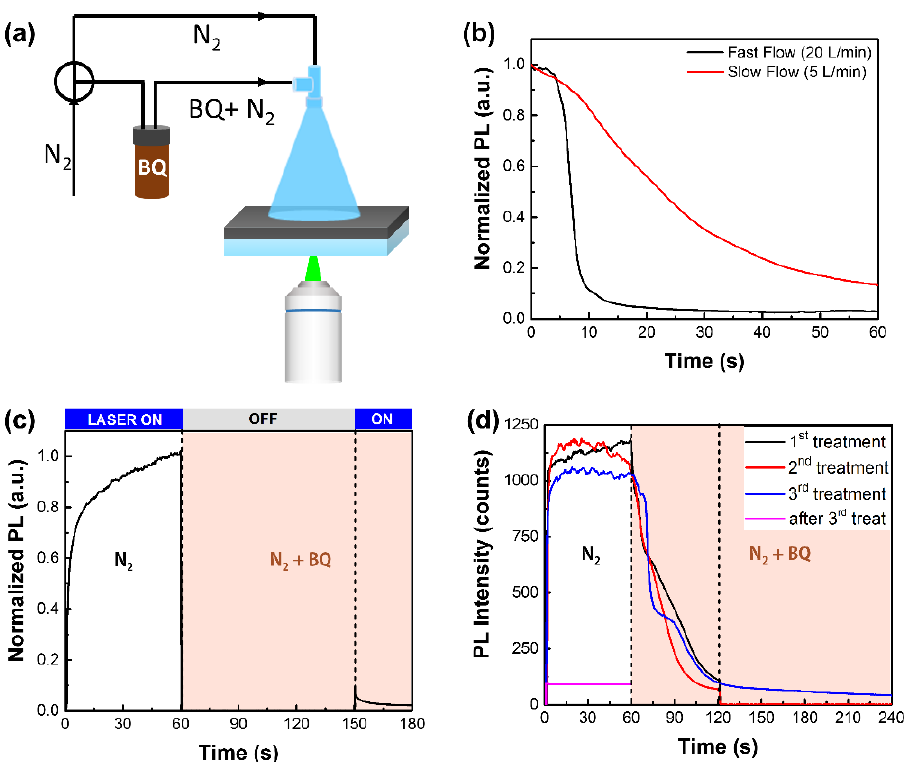
Figure 1. ( a ) Experimental setup of BQ vapor treatment method. By switching the T-valve, we can change the purge atmosphere between pure N 2 and BQ/N 2 ; ( b ) PL-quenching kinetics during BQ vapor treatment of different gas flow velocities demonstrate that PL quenching reaches saturation more quickly with faster flow velocity; ( c ) PL-quenching kinetics show a strong quenching effect of pure BQ adsorption without light irradiation; ( d ) repeated BQ treatment on the same region for different irradiation time. The sample was illuminated for 60 s in the first and second treatment and 180 s in the third one in BQ/N 2 . Only with longer irradiation in the third treatment could PL not recover back to the original level. All above treatment was under the irradiation of 0.2 W/cm 2 and 532 nm, and the gas flow rate is 5 L per minute, besides in Panel b.